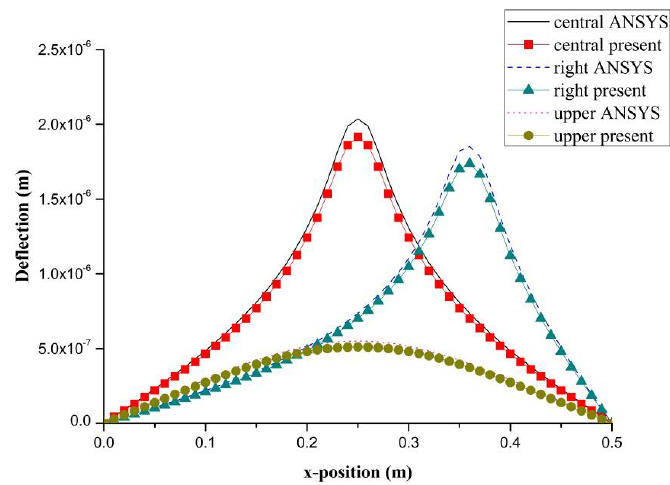
Figure 9. Deflection along the horizontal line (y = 0.25 m) of the composite laminate plate induced by a PZT actuator at three different locations.